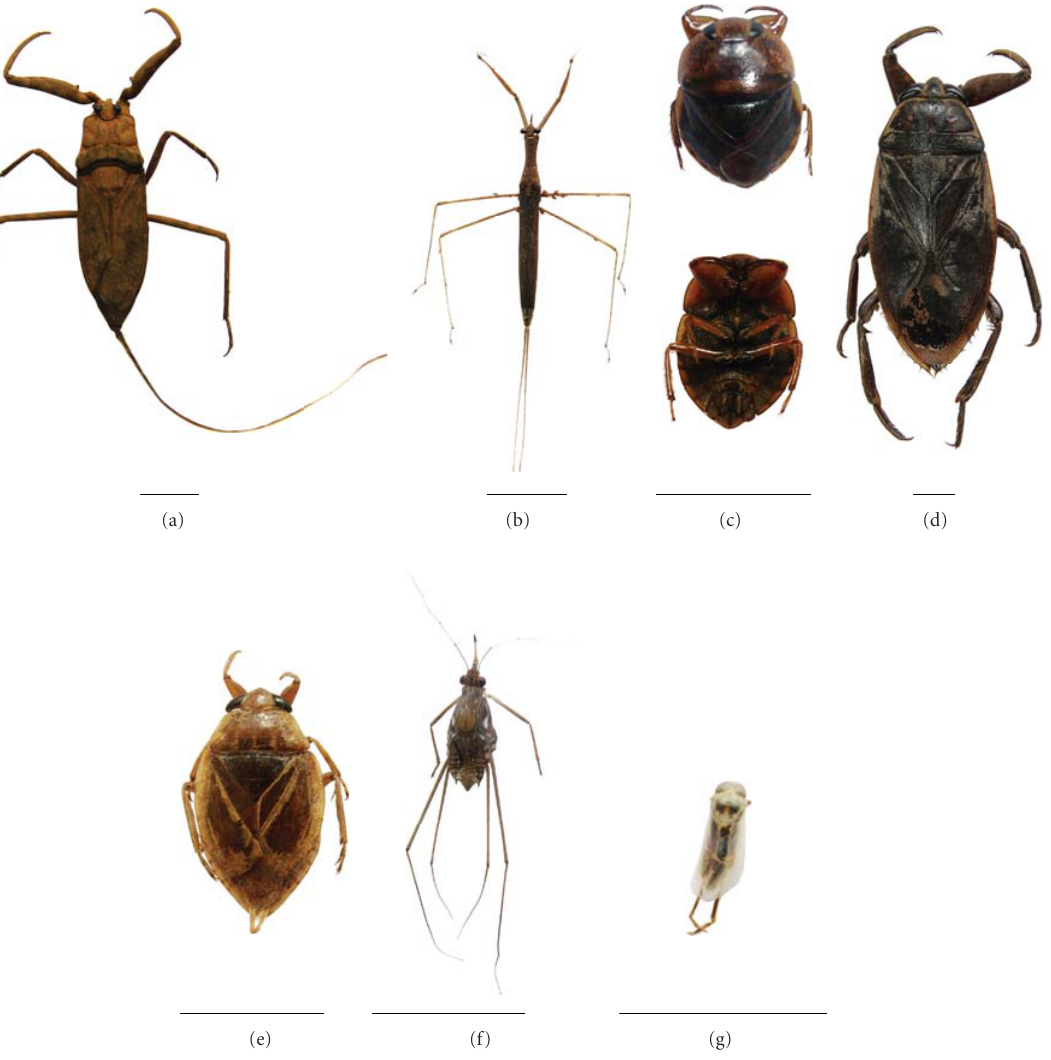
Figure 4: Specimens of water bugs collected during the study. (a) Nepinae, (b) Ranatrinae, the two subfamilies of Nepidae, (c) Naucoridae family (dorsal and ventral views), two morphotypes Belostomatidae, (d) giant Belostomatidae, (e) small size Belostomatidae, (f) Gerridae, and (g)